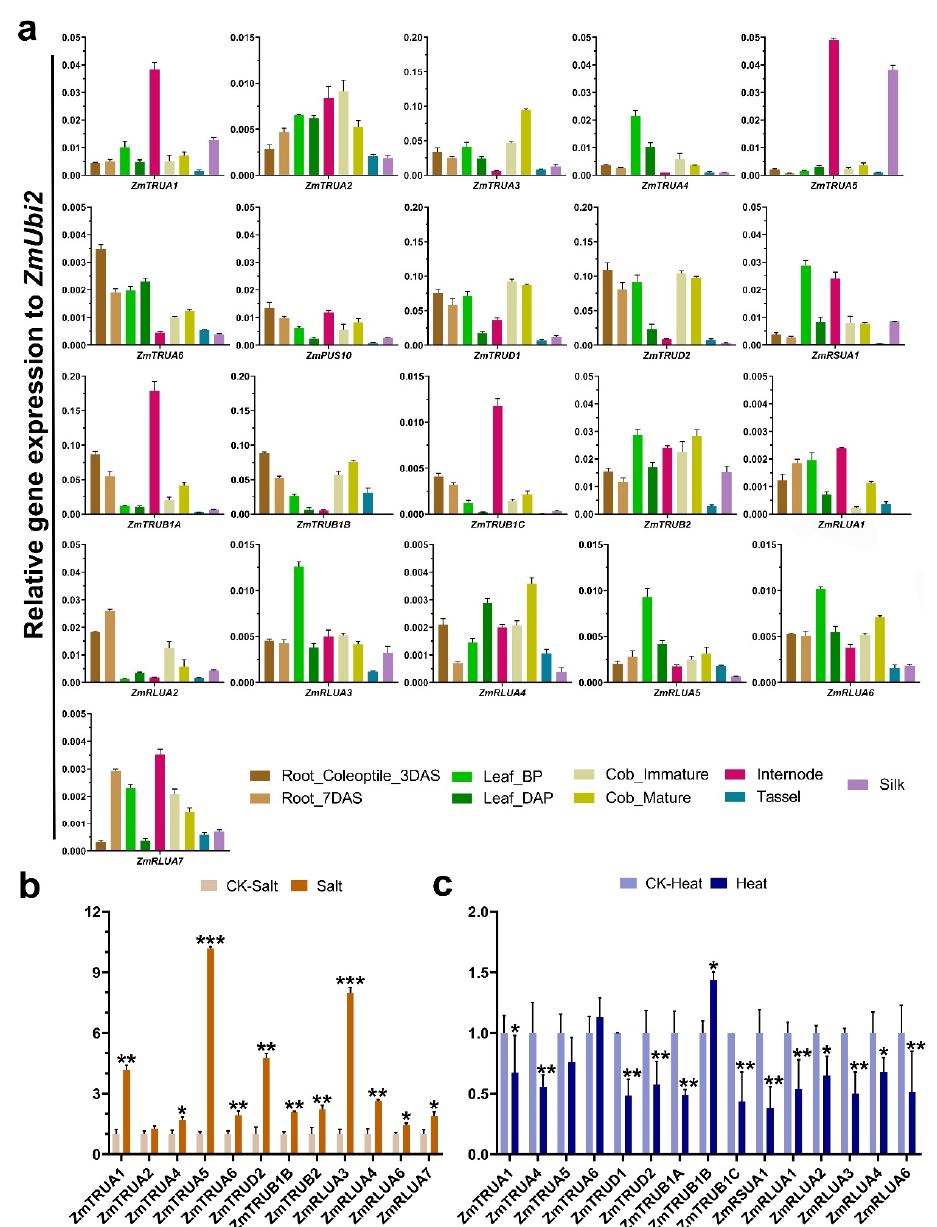
Figure 8. Expression profiles of ZmPUS genes in different tissues/organs and in reponse to abiotic stress. ( a ) Quantitative real-time PCR for ZmPUS genes in different tissues/organs. Root_Coleoptile_3DAS, primary root and coleoptile 3-day after sowing; Root_7DAS, root system 7-day after sow- ing; Leaf_BP, leaves before pollination; Leaf_DAP, leaves day after pollination; Internode, internode 6th–7th; Cob_immature, immature cob; Cob_mature, mature cob; Tassel, unpollinated tassel; Silk, unpollinated silk. The y axis indicated the relative expression value to ZmUbi2 . ( b ) Quantitative real- time PCR for ZmPUS genes in salt stress. ( c ) Quantitative real-time PCR for ZmPUS genes in heat stress. The expression of each sample treated by different abiotic stress were normalized by the cor- responding control (CK). Student T-test were applied for the significance statistical analysis. The asterisk indicated the significance of difference between the control and stress-treated samples, * p < 0.05, ** p < 0.01, *** p < 0.001.